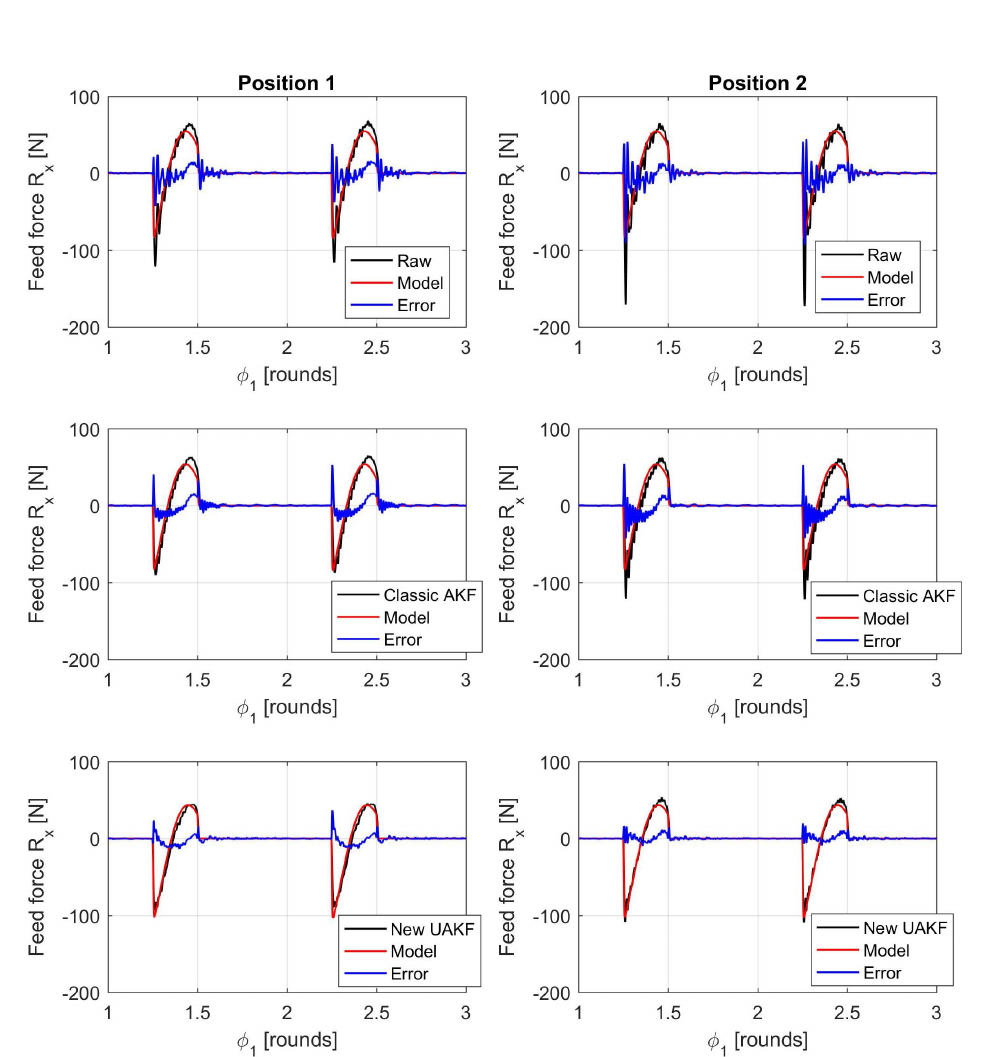
Figure 6. Comparison between filtered cutting forces and cutting force model along the feed direction X ( a p = 0.8 mm, f z = 0.14 mm). The two subfigures on the top show the raw cutting forces derived from Equation (2). The two subfigures in the middle show the filtered cutting forces obtained from the classical AKF that was based on both direct and cross TFRFs. The two subfigures on the bottom show the filtered cutting forces obtained from the novel UAKF approach. Moreover, all subfigures on the left refer to position 1 (milling bass beginning) while all subfigures on the right refer to position 2 (milling pass